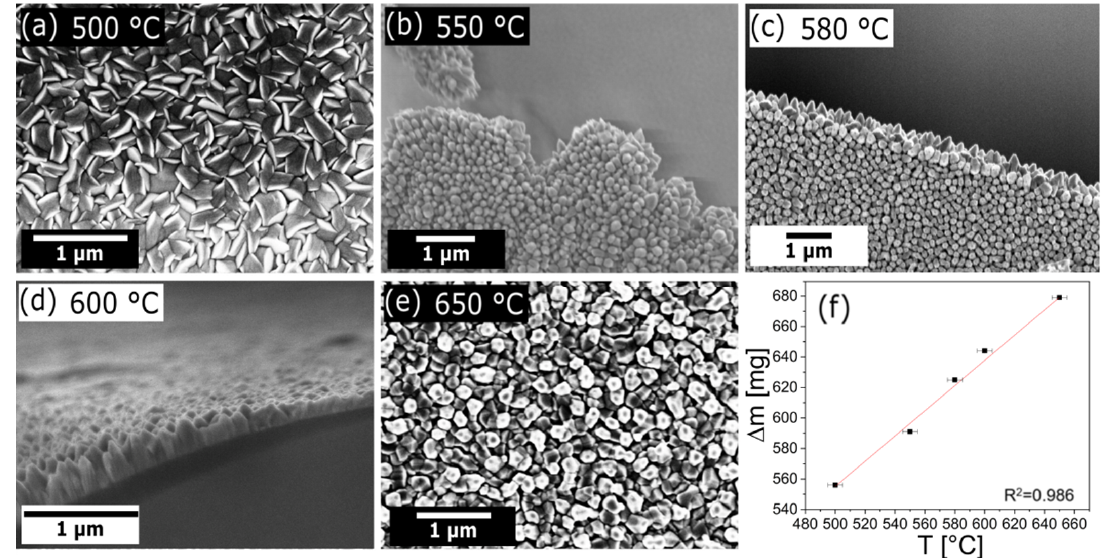
Figure 3. SEM images of ZnO nanostructures formed at different growth temperatures. The morphology of the structures varied from polycrystalline films ( a , e ) to nanowhiskers ( b – d ) with different characteristics of the surface facets and tips as a function of temperature. The structures are fabricated by using 50 sccm Ar and 25 sccm O 2 . ( f ) The consumption of the zinc acetylacetonate hydrate powder showed a linear dependence in the temperature range with a rate of 0.83 ± 0.04 mg/°C.